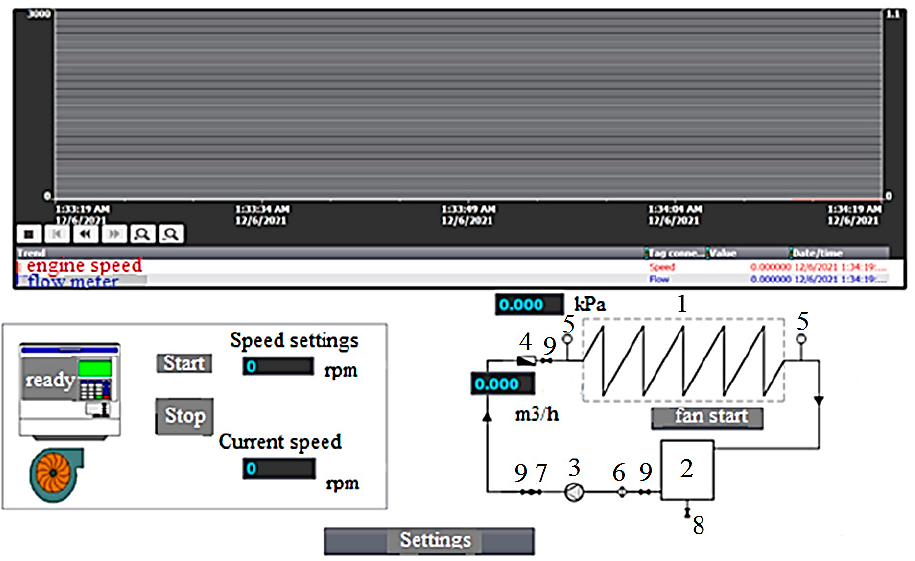
Figure 8. Virtual control desk of the laboratory stand (where 1—coil (pipe); 2—water tank; 3—pump; 4—flow meter; 5—pressure sensor; 6—sump filter; 7—check valve; 8—drain ball valve; and 9—ball